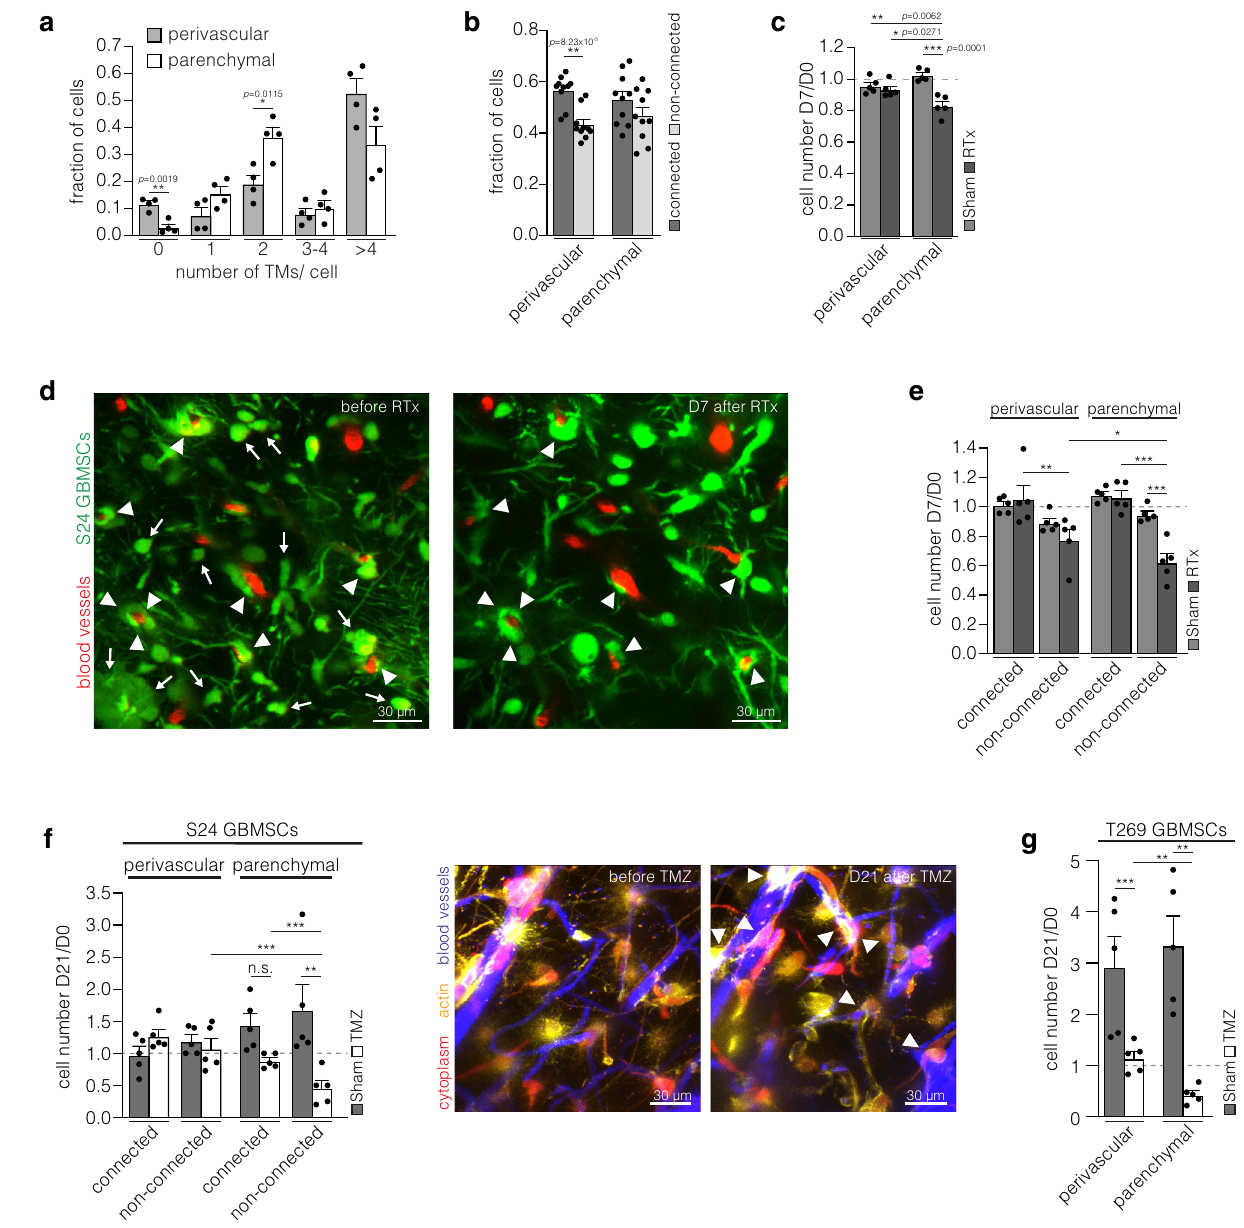
Fig. 4 Both perivascular and network glioma cells are particularly resilient. a Analysis of fractions of cells with different number of TMs (S24 glioblastoma stem-like cells (GBMSCs), D41, n = 4 regions in 3 mice, 52 – 104 cells, two-tailed t -tests). b Analysis of the connectivity of cells in the perivascular and parenchymal compartment (S24 GBMSCs, D65 ± 4, n = 10 regions in 6 mice, 148 – 259 cells, two-tailed t -tests). c Ratio of tumor cell counts in the same regions 7 days after and before sham treatment or irradiation (RTx) (S24 GBMSCs, n = 5 regions in 3 mice per group, one-way ANOVA ( p = 0.0002), Tukey ’ s post hoc test). d Representative 2-PM images of the same tumor region before and 7 days after radiotherapy demonstrate that perivascular glioma cells are largely radioresistant (S24 GBMSCs). Arrows: disappearing parenchymal tumor cells. Arrowheads: surviving perivascular tumor cells. e Ratio of tumor cell counts in the same regions 7 days after and before sham treatment or irradiation (RTx) categorized by connectivity and compartment (S24 GBMSCs, n = 5 regions in 3 mice per group, one-way ANOVA ( p = 1.55; × 10 − 6 ), Student – Newman – Keuls post hoc test). The analysis revealed that non-connected tumor cells in the parenchyma are most susceptible for the cytotoxic effects of radiotherapy. In contrast, non-connected cells in the PVN are more radioresistant, thereby demonstrating the protective environment promoted by the PVN. In the PVN, interconnection has an additive effect on radioresistance. f Left: Ratio of cell counts of S24 GBMSCs in the same regions 21 days after and before temozolomide or sham treatment ( n = 5 regions in 3 mice per group, one-way ANOVA on ranks ( p = 0.0018), Student – Newman – Keuls post hoc test). Right: Exemplary 2-PM images before and 21 days after temozolomide treatment in S24 GBMSCs. Arrowheads: surviving perivascular GBMSCs. g Ratio of cell counts of T269 GBMSCs in the same regions 21 days after and before temozolomide or sham treatment ( n = 5 regions in 3 mice per group, one-way ANOVA on ranks ( p = 0.0002), Student – Newman – Keuls post hoc test). Data a – c , e – g are represented as mean + SEM. * p < 0.05, ** p < 0.01, *** p < 0.001, n.s. = not signi fi cant. Source data are provided as a Source Data fi